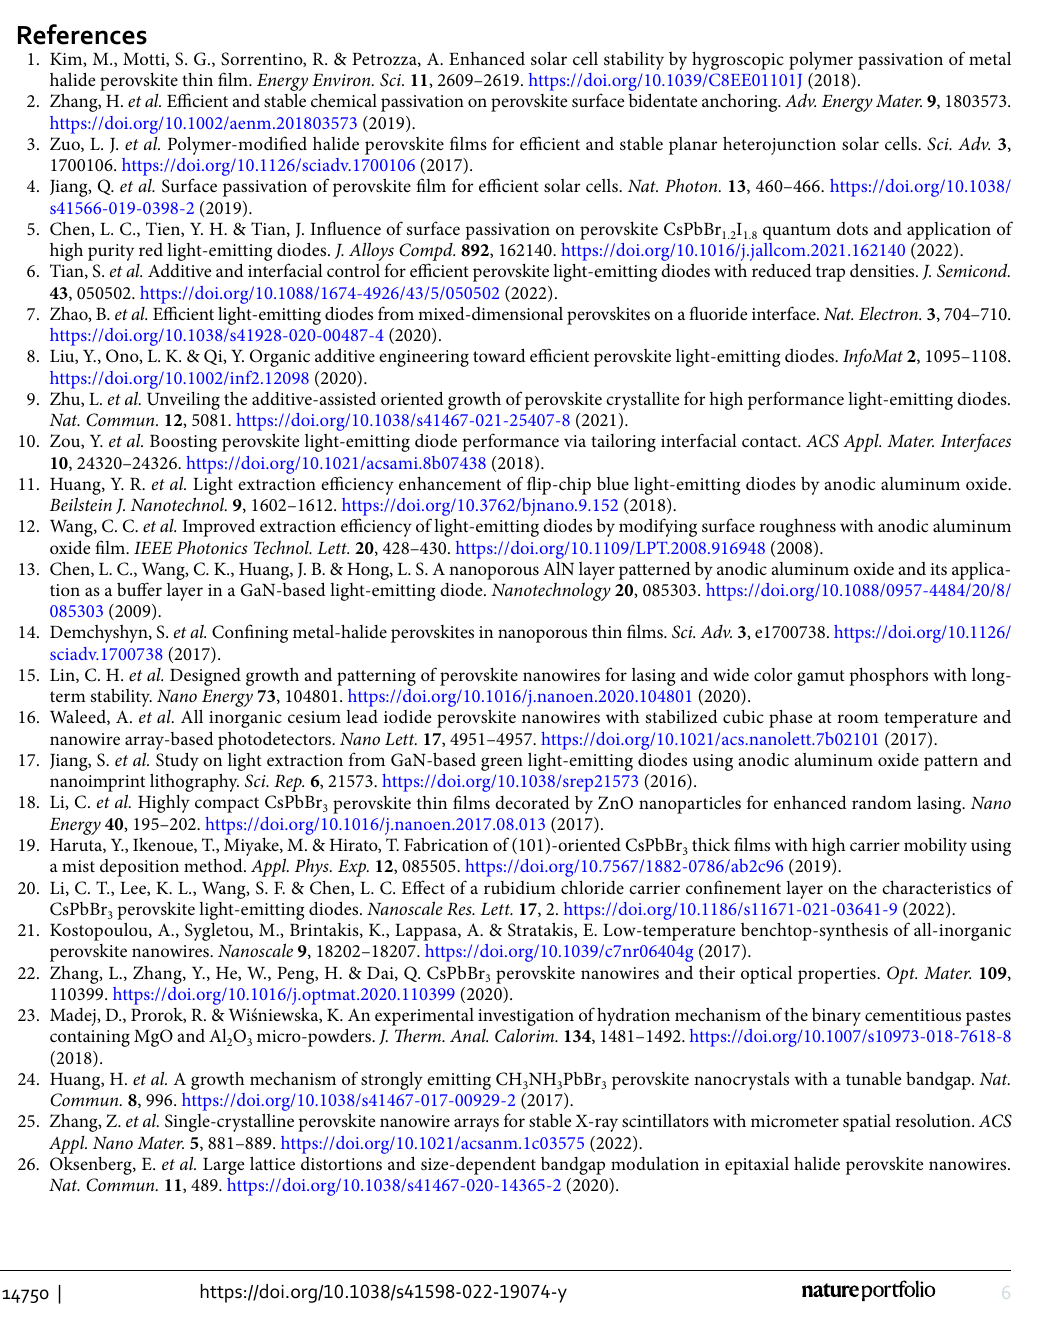
Fig. 7b–d. To compare the CsPbBr3 PeLEDs with an EQE over 20%, the current efficiency of this work is lower one order 31,32 . The future work of PeLED should be in capping layer and passivation of non-radiative defects.